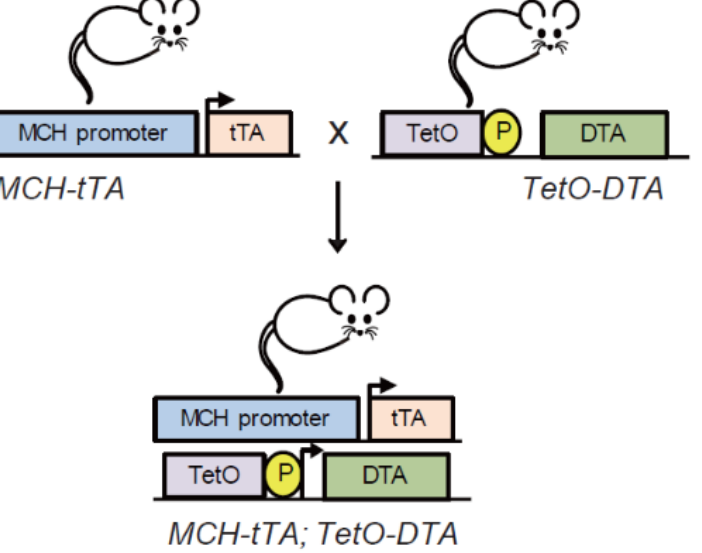
Figure 1. Generation of MCH-tTA; TetO DTA bigenic mice. Cell-specific stratagem of innate MCH neurons ablation observed congenitally in the bigenic mice. Tetracycline-controlled gene expression and tTA-induced DTA ablation observed specifically in MCH neurons (Modified from Tsunematsu et al. [42]).